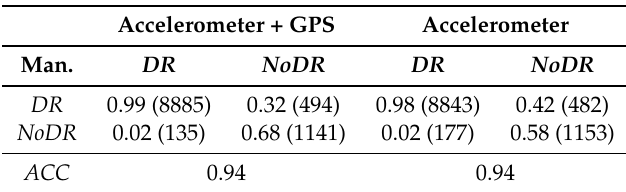
Table 15. Coarse-grained classifier’s confusion matrices with and without GPS enrichment.